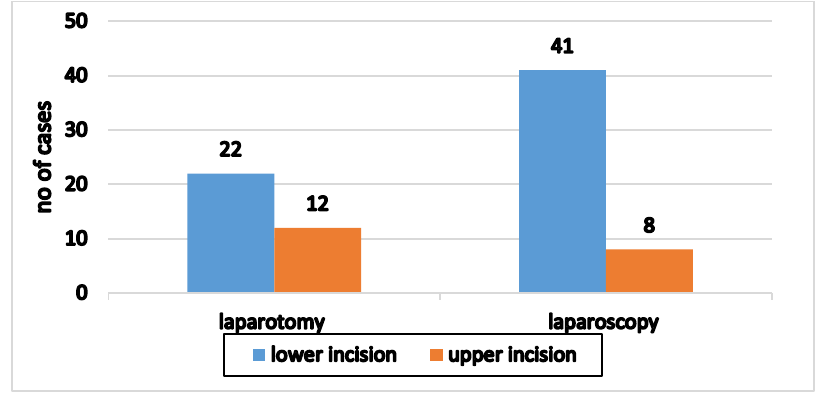
. Figure 1 : Association between previous abdominal insecion and type of cholycestictomy